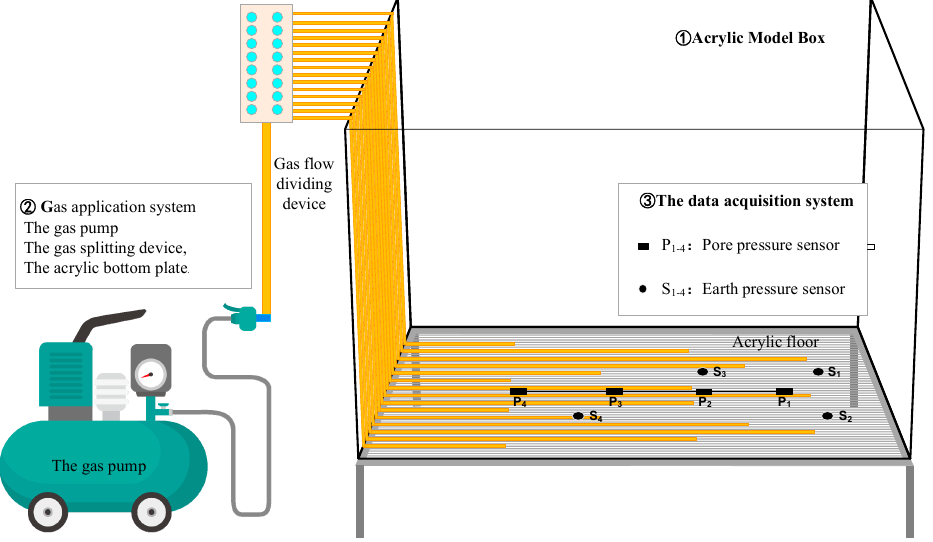
Figure 2. Schematic diagram of the test device.